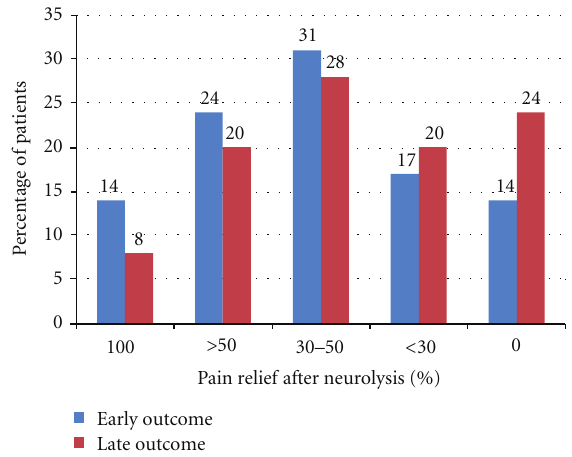
Figure 3: E ffi cacy of endoscopic ultrasound-guided celiac plexus neurolysis: (i) early outcome (1-2 weeks after treatment), (ii) late outcome (2-3 months after